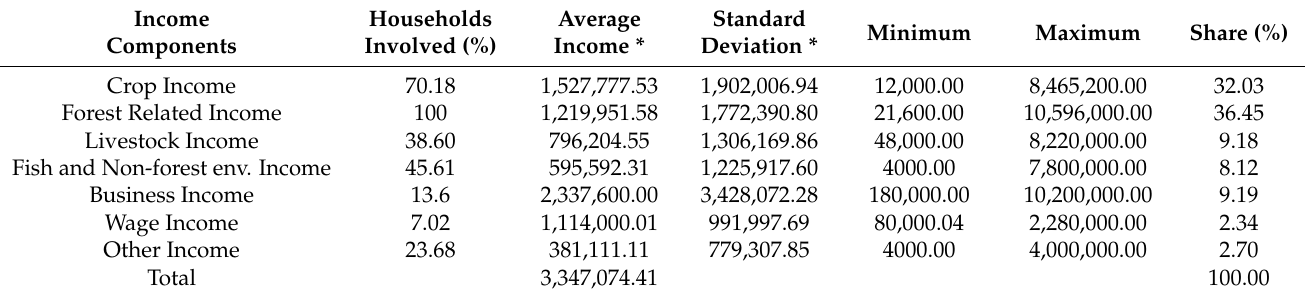
Table 3. Forest dependents involved in livelihood strategies, average annual income per income source (in CDF) and shares by income